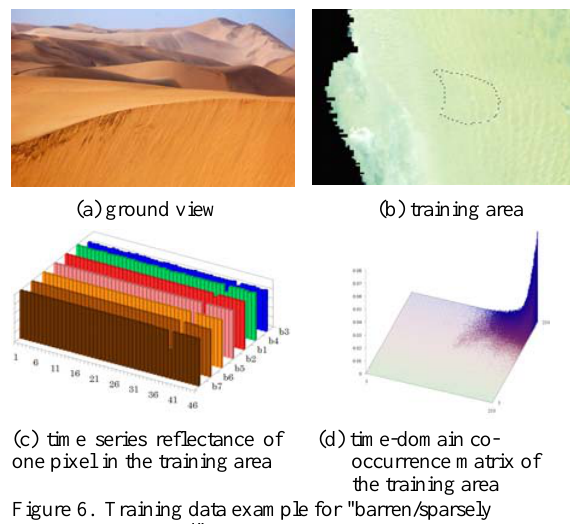
Figure 6. Training data example for "barren/sparsely vegetated". Classification accuracies were measured by using test samples of 300 pixels that were sampled randomly from training area of each individual class.